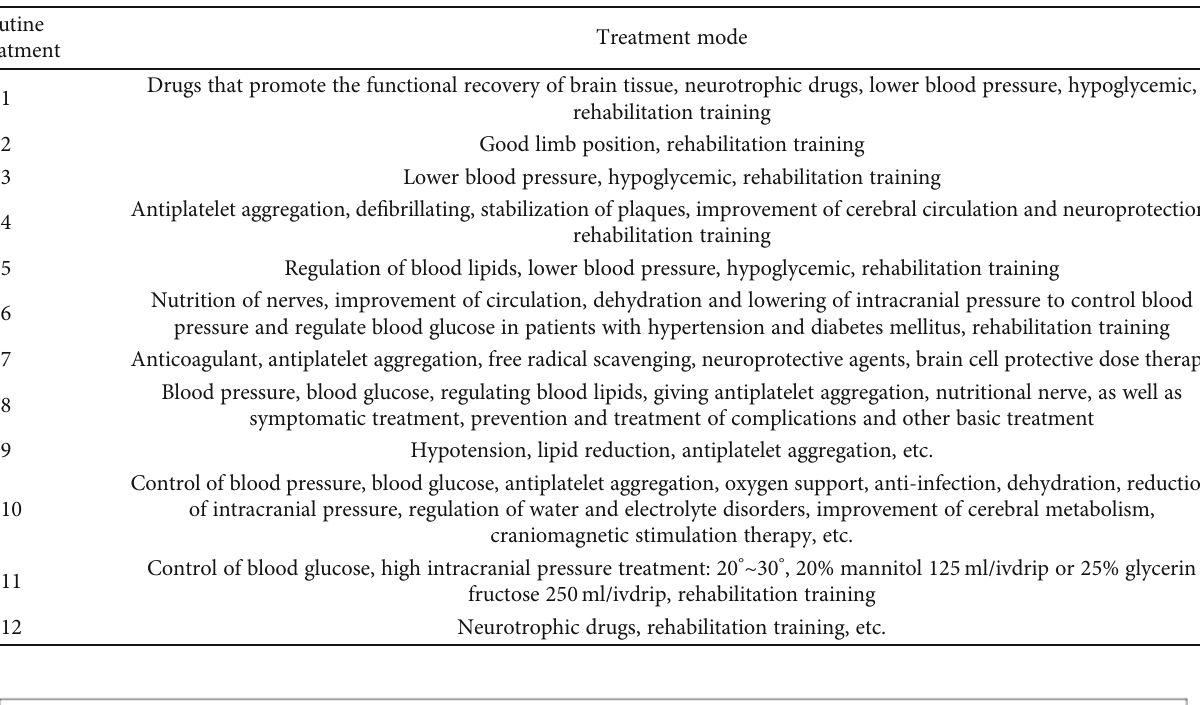
Table 5: Acupuncture control group.